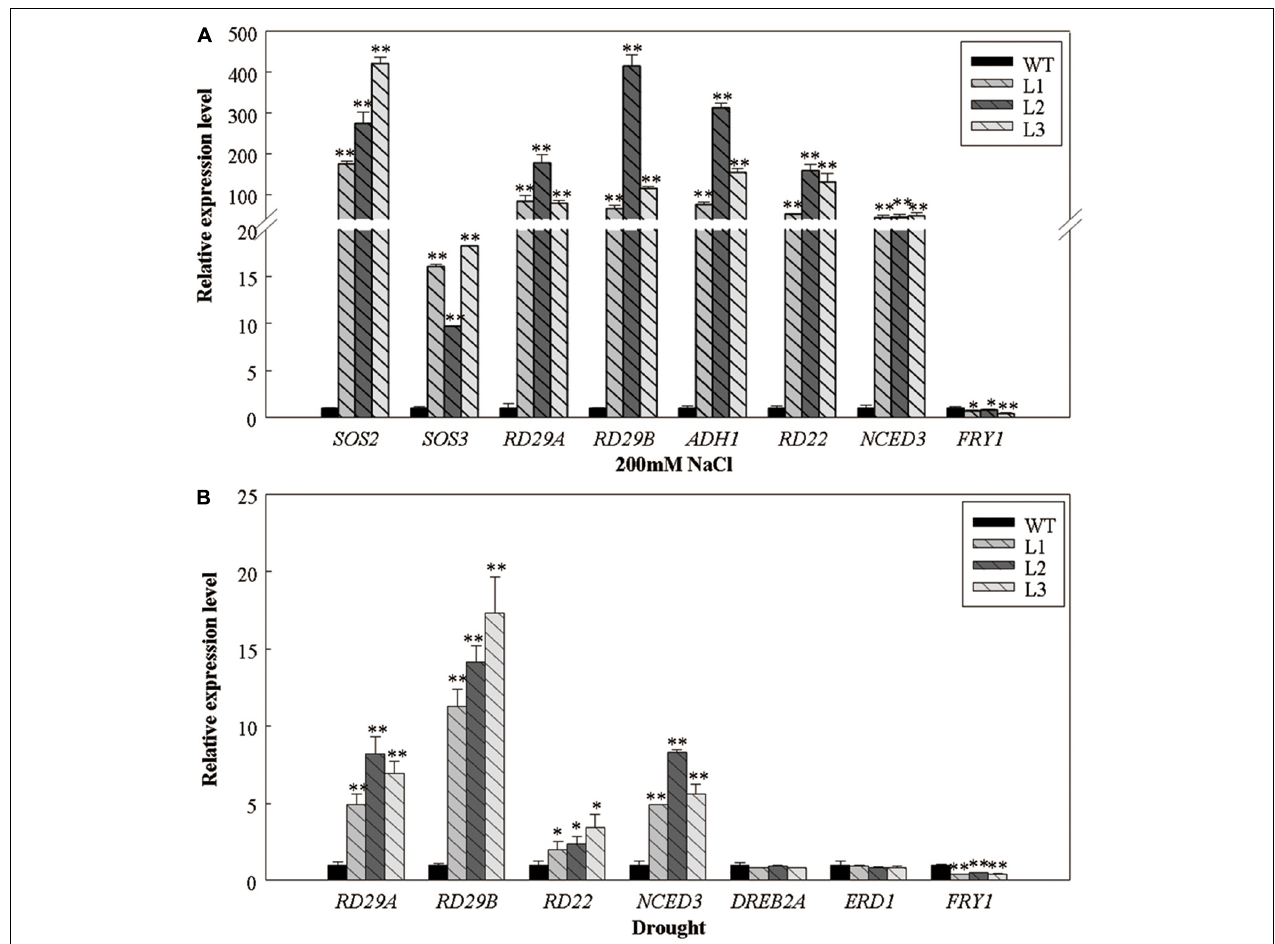
FIGURE 6 | Expression levels of abiotic stress-responsive genes in WT and VlWRKY3 transgenic Arabidopsis thaliana plants following exposure to abiotic stresses. (A) The relative expression levels of salt stress-responsive genes in WT and transgenic plants treated with 200 mM NaCl for 7 days. (B) The relative expression levels of drought stress-responsive genes in WT and transgenic plants deprived of water for 7 days. Relative gene expression levels were analyzed using quantitative real-time RT-PCR. Bars represent the mean ± SD of three independent experiments. Asterisks indicate statistical significance ( ∗ 0.01 < P < 0.05, ∗∗ P < 0.01, Student’s t -test) of differences between transgenic lines and WT